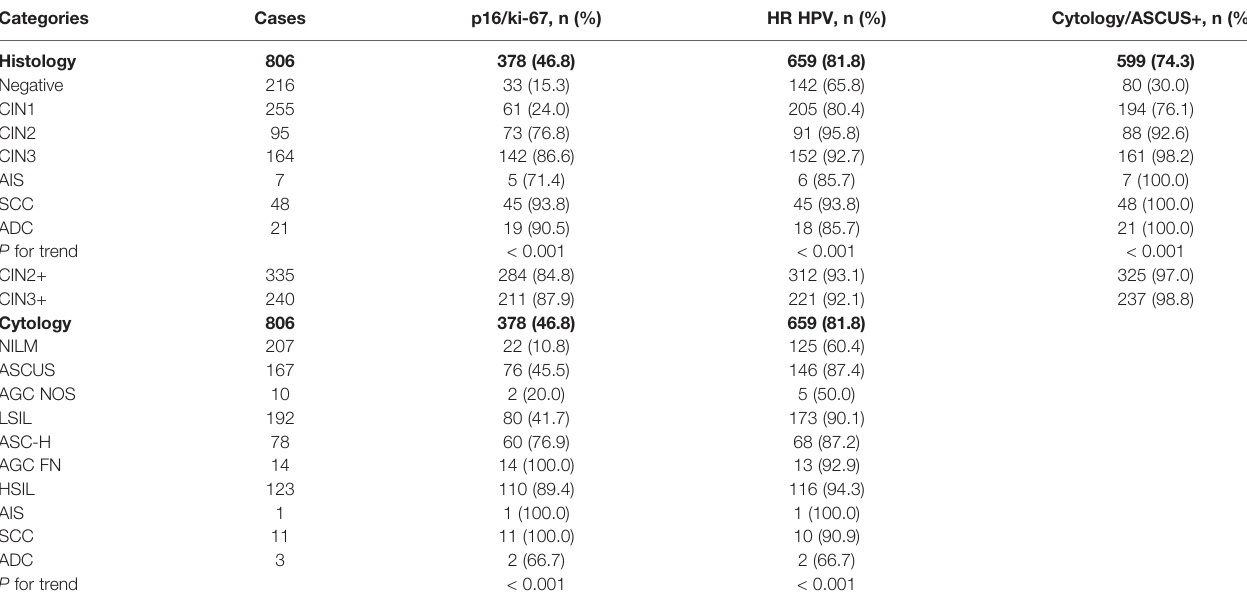
TABLE 1 | Positivity of p16/ki-67, cytology and HR HPV in histology and cytology